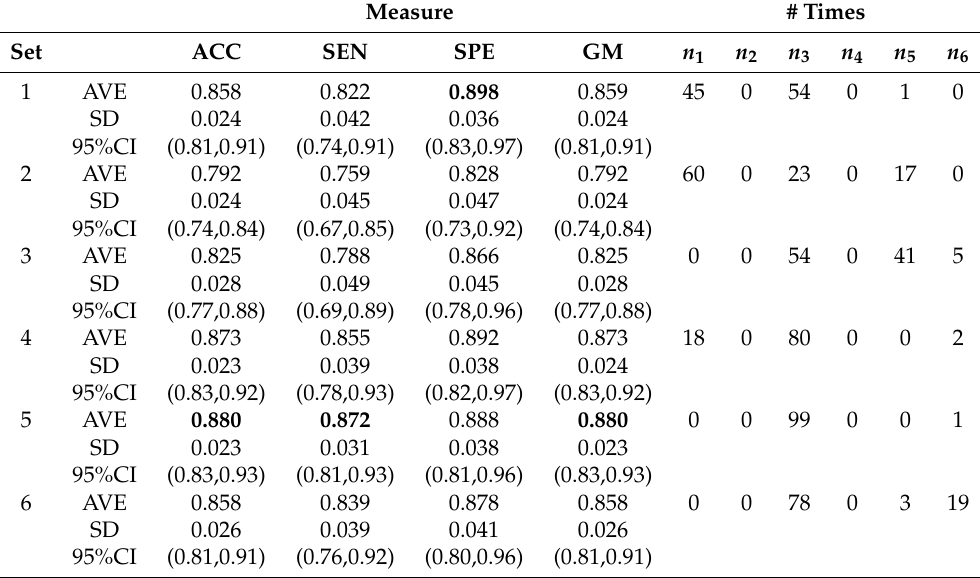
Table 3. The AVEs, SDs, and 95% CIs of the ACC, SEN, SPE, and GM values of 6 collections of features for the test data based on 100 rounds, where the highest AVEs of the ACC, SEN, SPE, and GM values among the 6 sets of features are marked in bold. In addition, n 1 , n 2 , . . . , and n 6 , respectively, denote